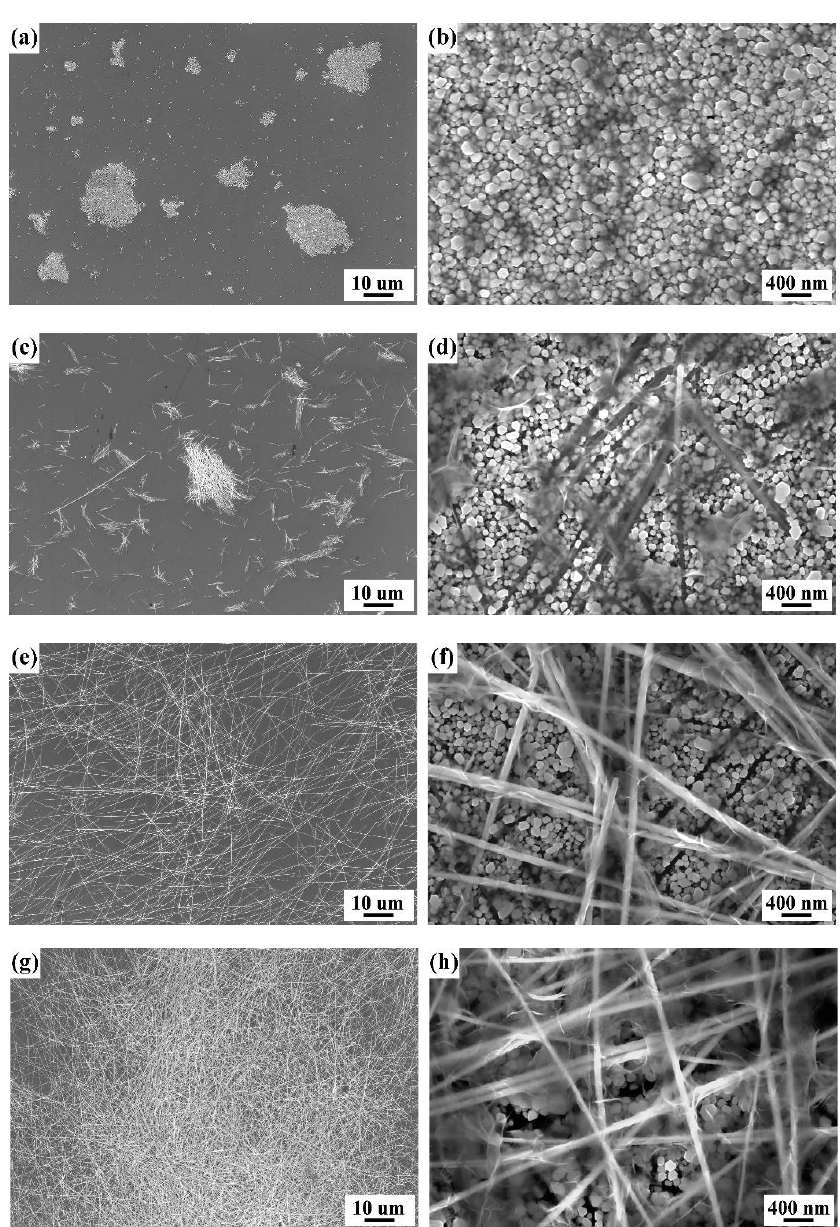
Figure 2. Top-view SEM images of the Ag NWs films on the AZO SL: ( a ) Ag1; ( c ) Ag2; ( e ) Ag3; ( g ) Ag4. The Ag NWs/AZO NRs composite films: ( b ) Ag1-AZO; ( d ) Ag2-AZO; ( f ) Ag3-AZO; ( h ) Ag4-AZO.